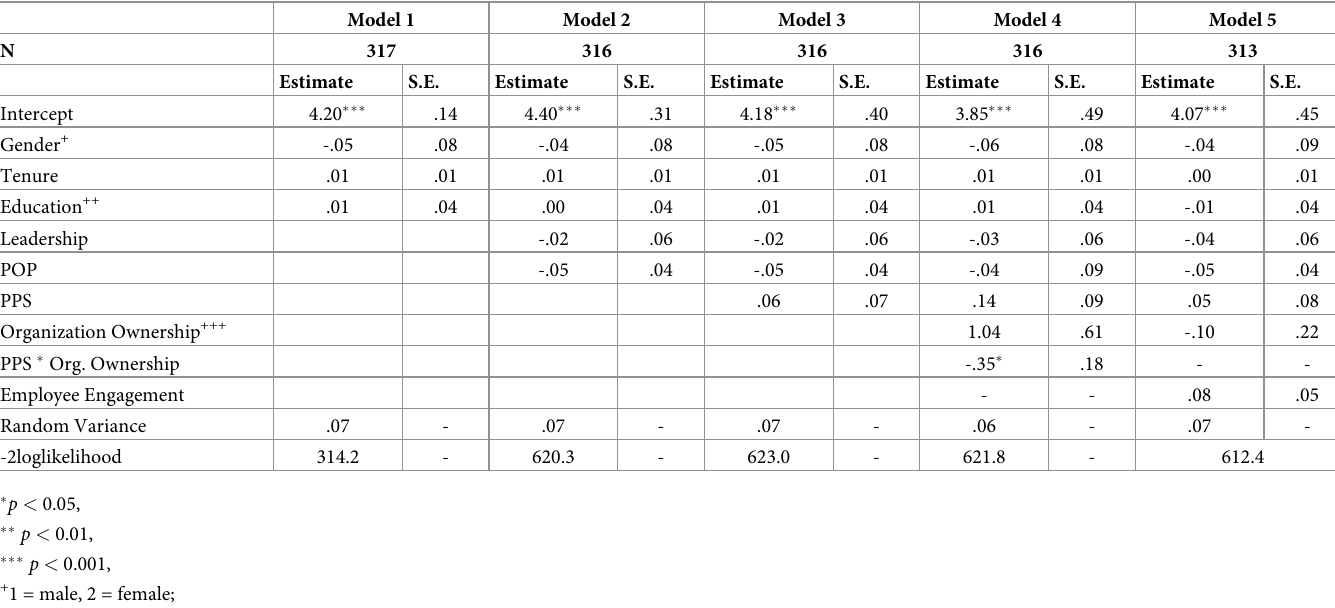
Table 4. Multi-level analysis with in-role performance as dependent